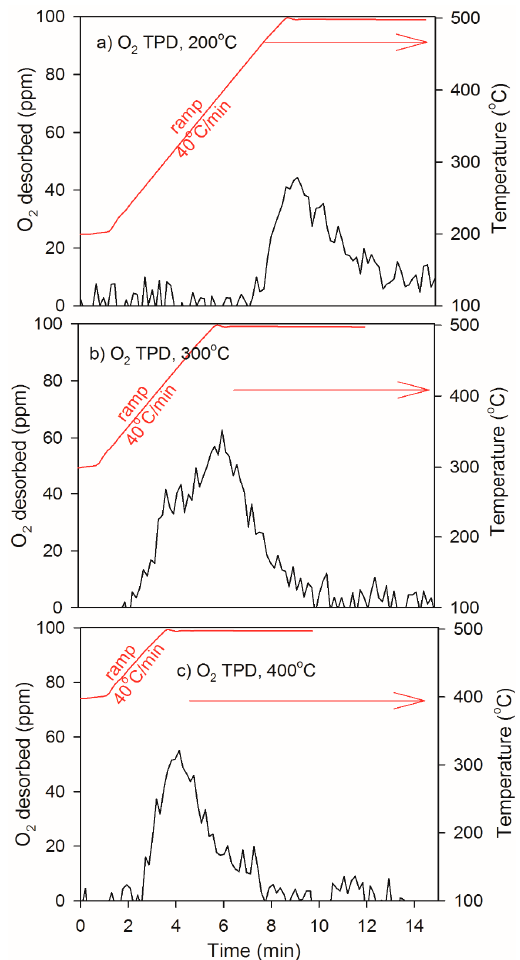
Figure 7. The amounts of the oxygen desorbed during temperature ramp for O 2 TPD at adsorption temperatures ( a ) 200 °C, ( b ) 300 °C, and ( c ) 400 °C. Experimental details are described in Section 3.